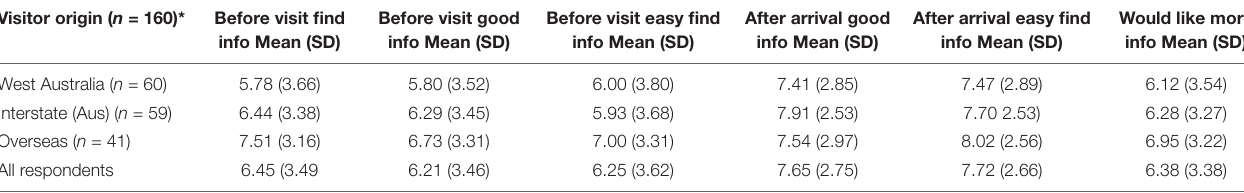
TABLE 4 | Visitors’ information seeking and trust in that information about the Ningaloo Coast WHA. Visitor origin ( n = 160)* Before visit find